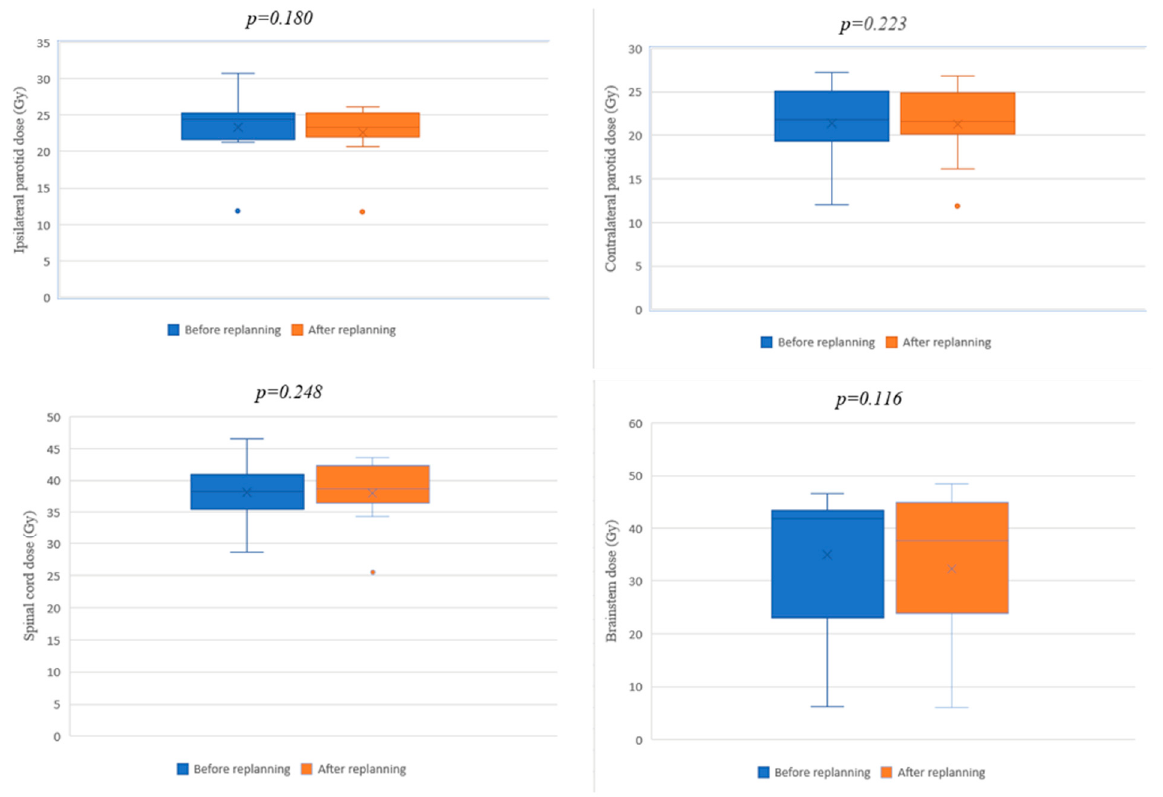
Figure 6. Box plot diagrams for OARs before and after replanning.